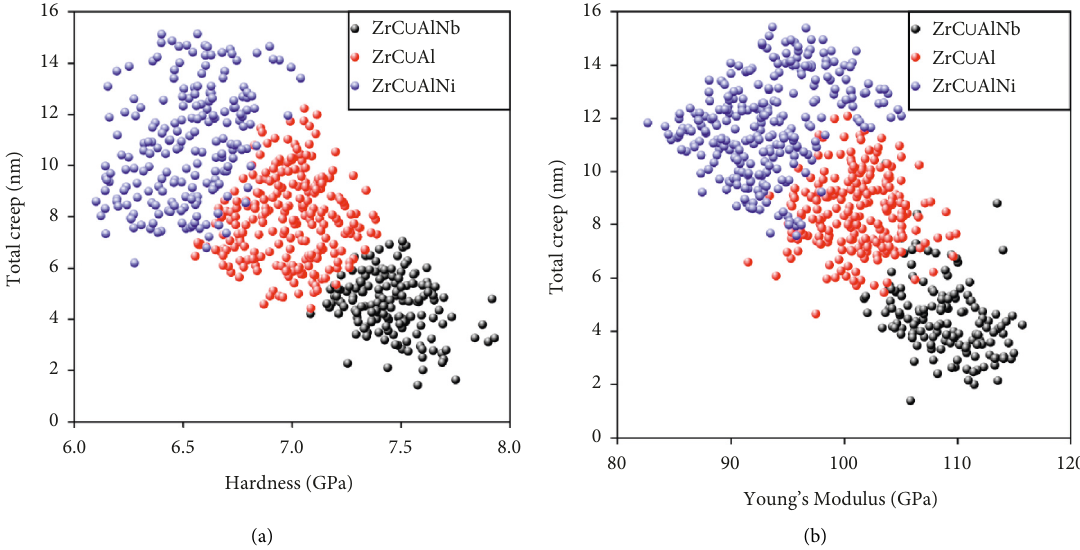
Figure 7: Total creep displacement as a function of (a) hardness and (b) Young’s modulus.